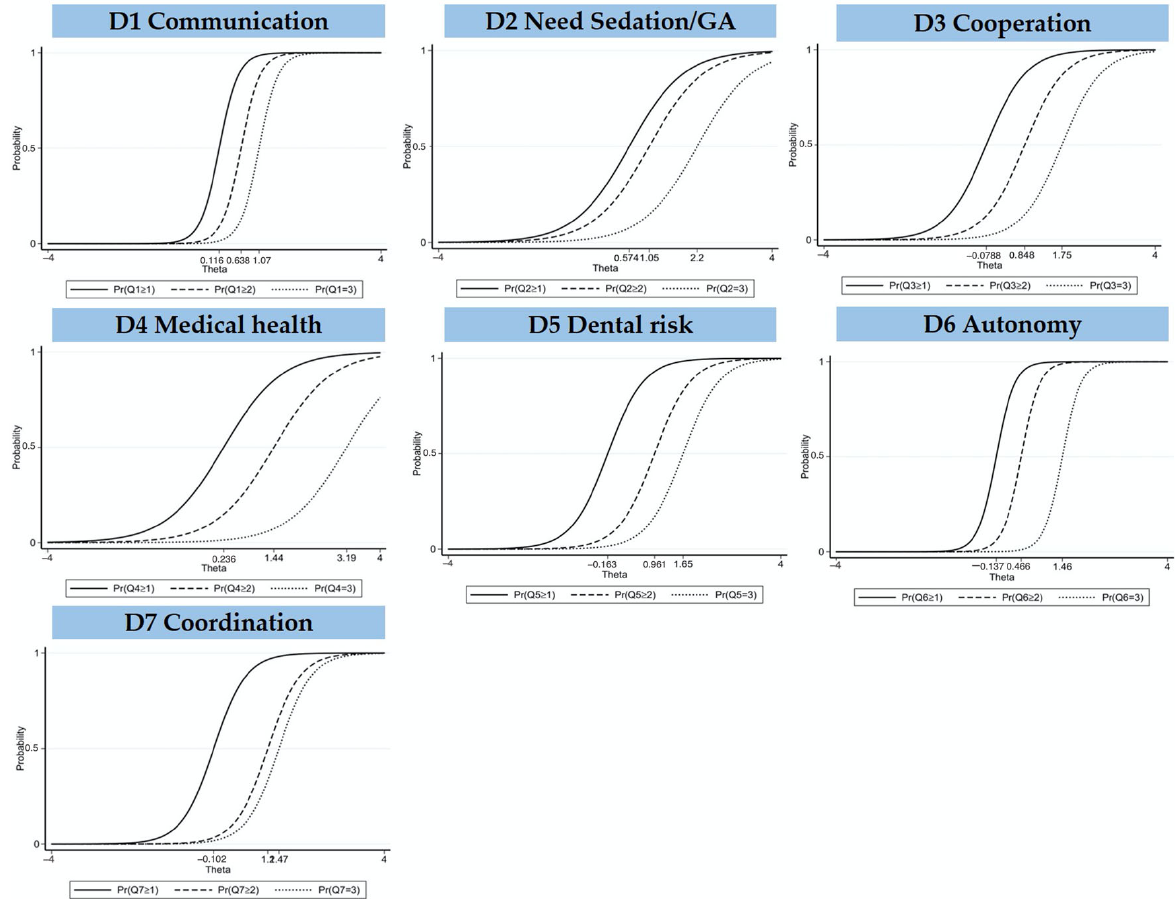
Figure 3. Item characteristic curves of the seven domains of the FCM.